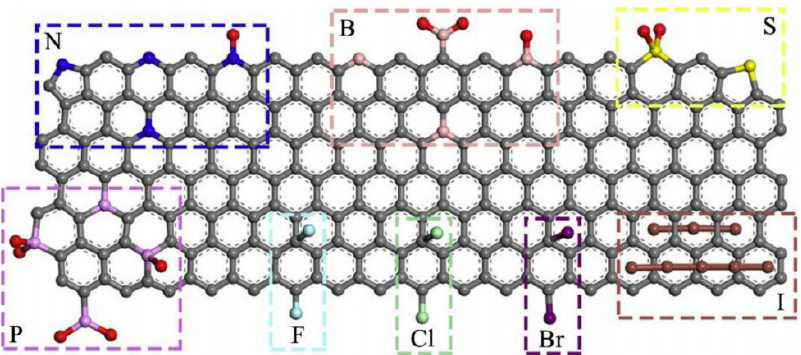
Figure 1. Different possibilities of heteroatom-doped graphene materials. Reproduced with per- mission [11].